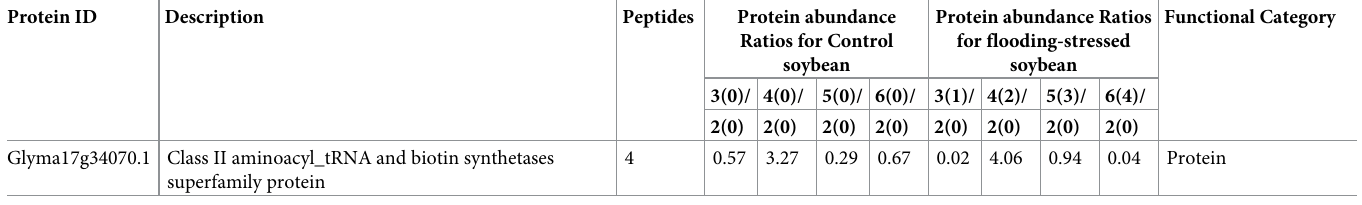
Among the total identified proteins in flooded and control soybeans, 42 common proteins increased in abundance 4-fold or more after 2-days flooding stress as compared to 2-days-old seedlings. The protein abundance changes in flooded plant proteins ranged from 4.06 to 57.06 fold when analyzed at 4(2). These proteins were subjected to cluster analysis that grouped pro- tein abundance changes in flooded plants into 3 clusters (Fig 4A). In the first cluster, protein abundance of majority of proteins was increased at 2 nd , 3 rd and 4 th day of flooding. Abun- dances of few proteins fell to the starting point at the end of 4-days flooding while a very few decreased. Cluster I contained 16 proteins that included cupin family protein (Gly- family protein (Glyma03g03460.1), Arabidopsis thaliana peroxygenase 2